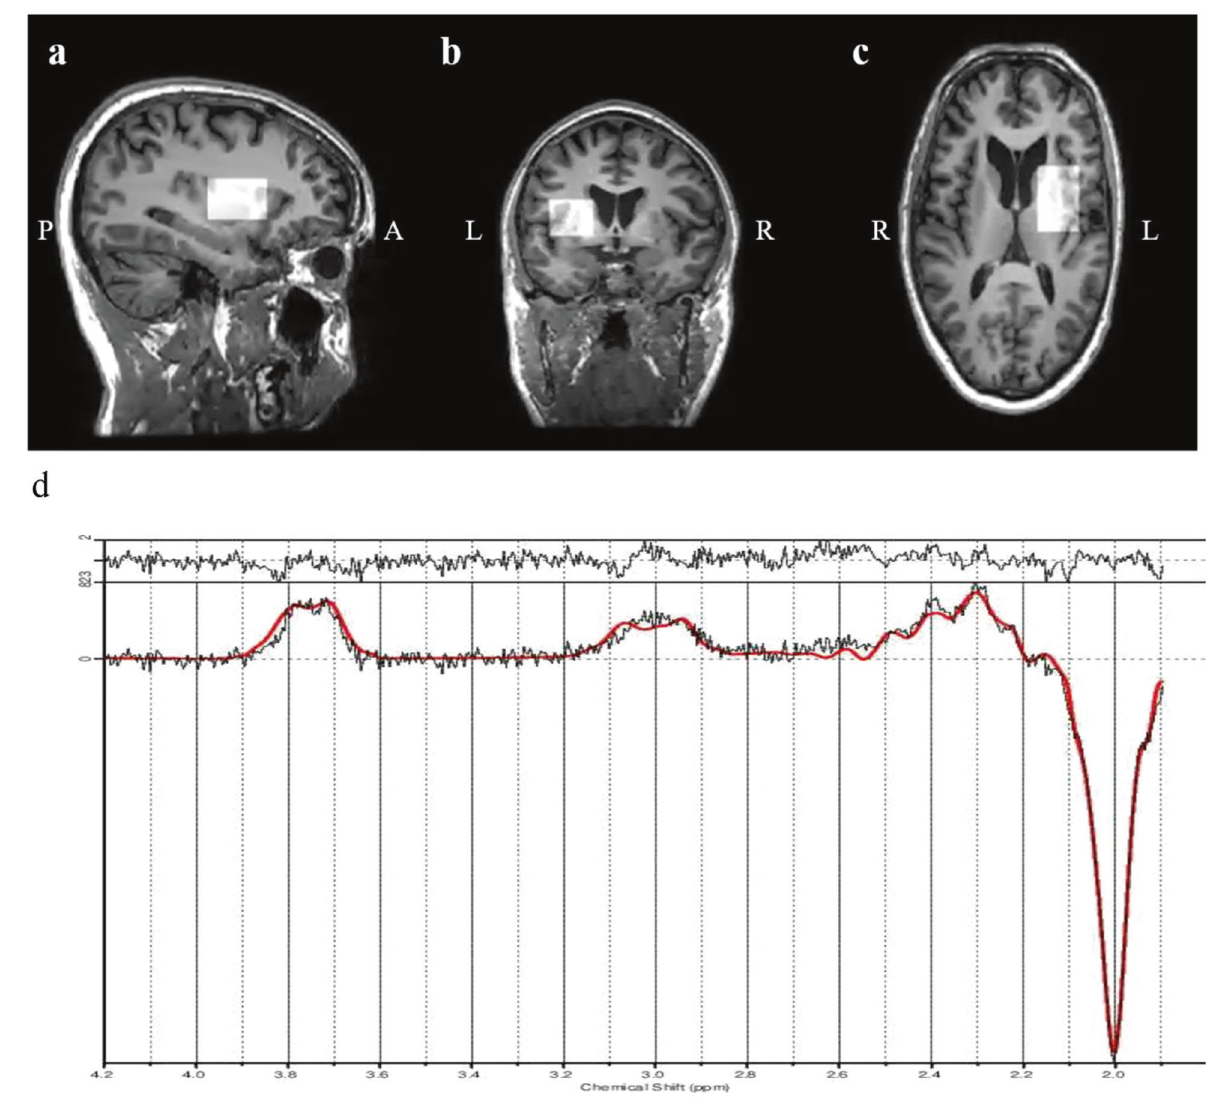
Fig. 1 Example of the position of the MEGA-PRESS voxel (3 × 3 × 3 cm 3 ) in the left striatum/thalamus. a Sagittal view; b Coronal view; c Axial view; d Difference spectrum from a representative participant (black line) and LCModel fi t (red line). Glx glutamate + glutamine, GABA + gamma- aminobutyricacid + macromolecules, tNAA n-acetylaspartate + n-acetylaspartylglutamate, MM macromolecules, ppm parts per